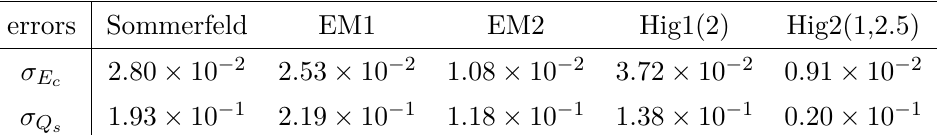
Table 1. Standard deviations of the various ABCs (see the text below eq. (2.14)) against the reference simulation for energy E ( t ) and charge Q ( t ) , which are defined in section 2.1. The c s reference simulation is set up such that the lattice is sufficiently large so that the radiation has not reached the boundaries at the end of the run. The Hig2(1,2.5) ABC has the best accuracy and is the default ABC used below unless stated